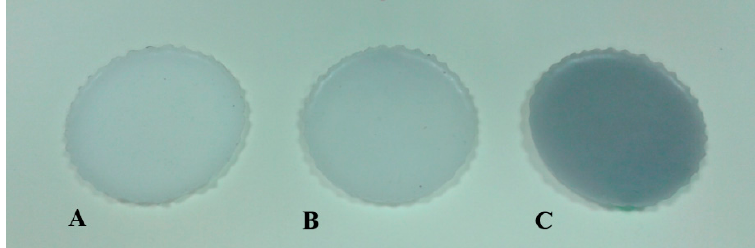
Figure 3. Produced phantoms. A —reference Ø = 45 mm, d = 2 mm; B —with the addition of India ink (5 µL) Ø = 45 mm, d = 2.6 mm; C —with the addition of India ink (20 µL) Ø = 45 mm, d = 2.3 mm.